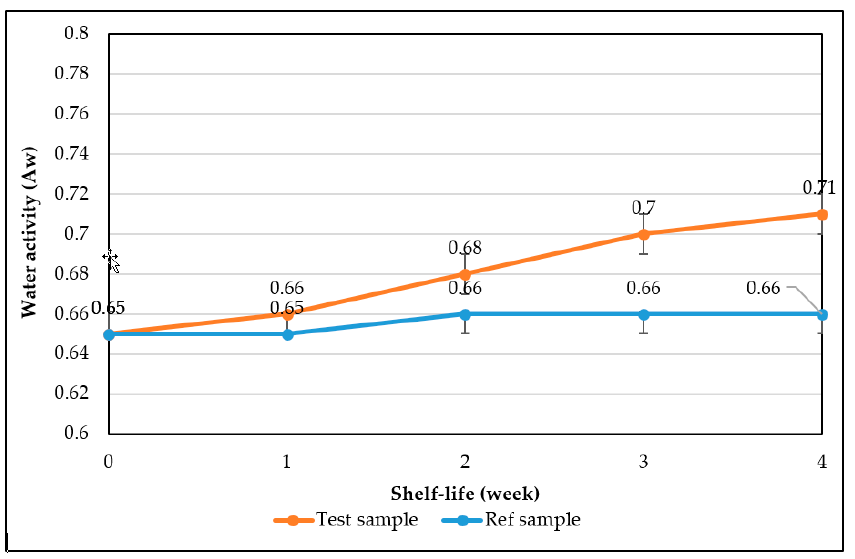
Figure 12. Water activity of sponge cake in accelerated condition 20 °C after various storage times.